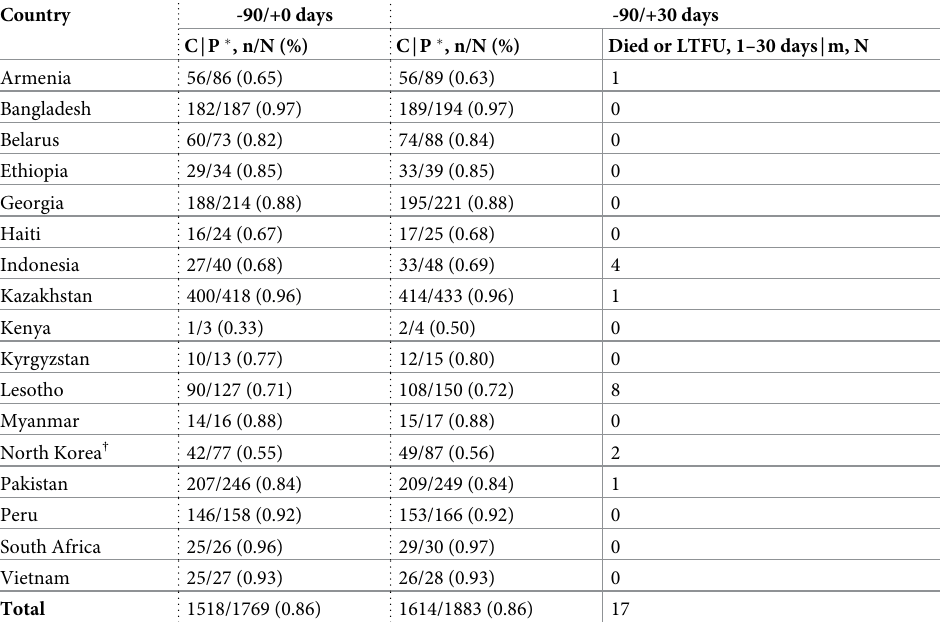
Table 2. Sputum culture conversion and early death and loss-to-follow up events among participants missing a sputum culture in the specified interval before (-) and after (+) treatment initiation, endTB observational cohort.